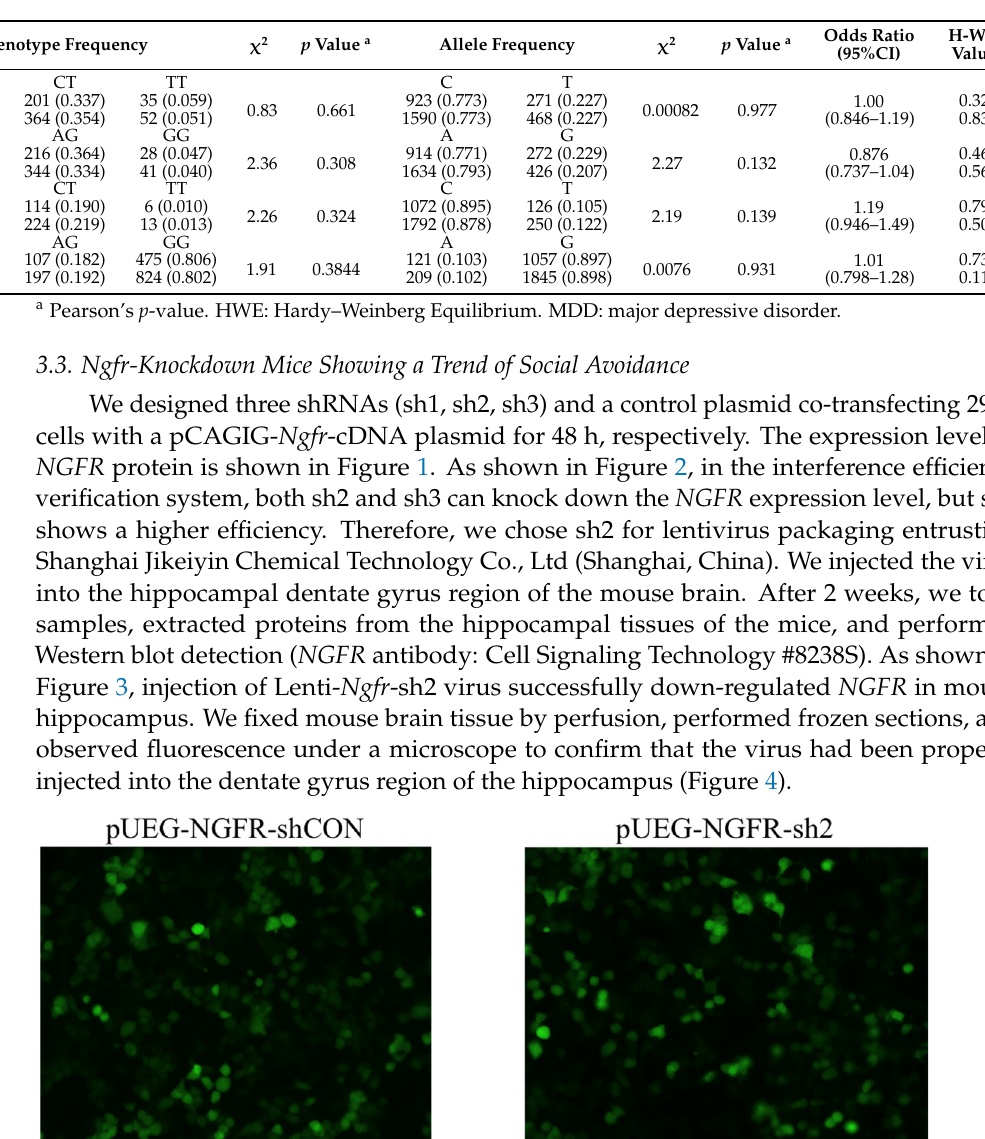
. Figure 2. Down-regulation of NGFR in 293T cells. ( A ) Immunoblotting of protein extracted from 293T cells co-transfected with shRNA plasmid and pCAGIG- Ngfr -cDNA. ( B ) One-way ANOVA of the protein levels after normalization to β -actin; data showed as means ± SEM, ** p < 0.01.